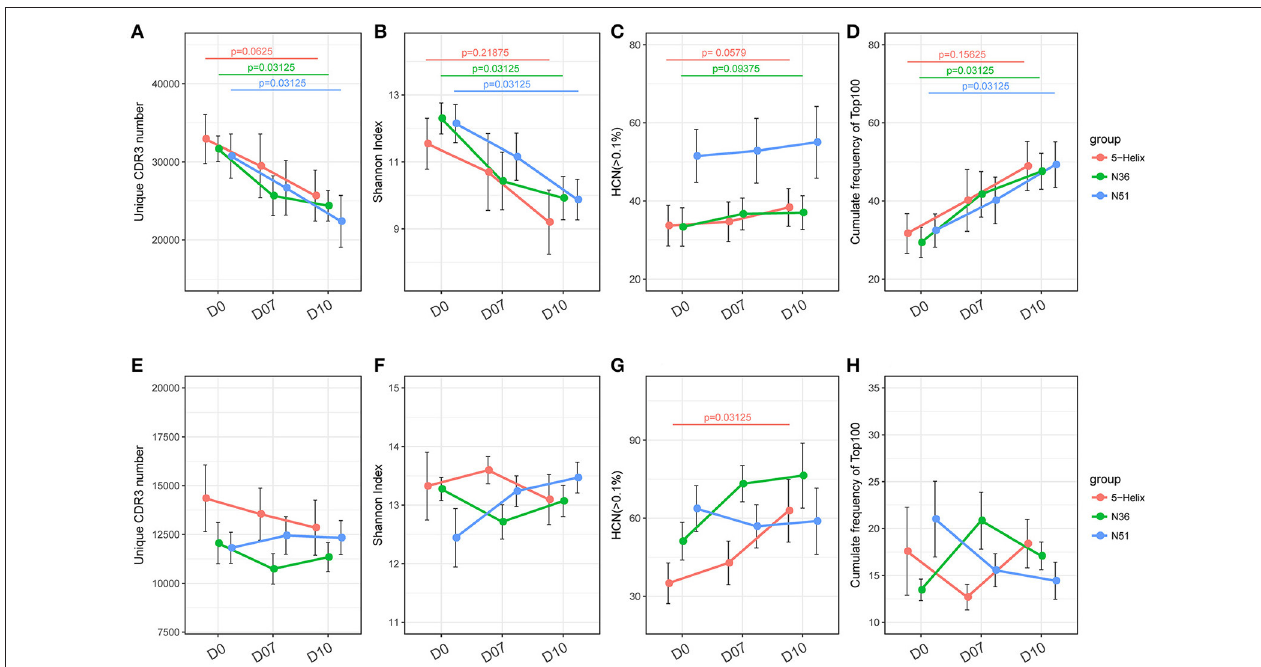
FIGURE 2 | Overall response of vaccination on TCR and IGH repertoires. (A–D) Unique CDR3 numbers, Shannon index, high frequency ( > 0.1%) clone numbers and the cumulative frequency of the top 100 clones of the TCR repertoire. Each point represents the mean value of a 6-macaque group at one time point with a bar of ± SEM. Red, green, and blue color represents 5-Helix, N36, and N51, respectively. Comparisons were performed using paired Wilcoxon test ( n = 6) (E–H). Unique CDR3 numbers, Shannon index, high-frequency ( > 0.1%) clone numbers and the cumulative frequency of the top 100 clones of the IGH repertoire. Each point represents the mean value of a 6-macaque group at one time point with a bar of ± SEM. Red, green, and blue color represents 5-Helix, N36, and N51, respectively. Comparisons were performed using paired Wilcoxon test ( n =